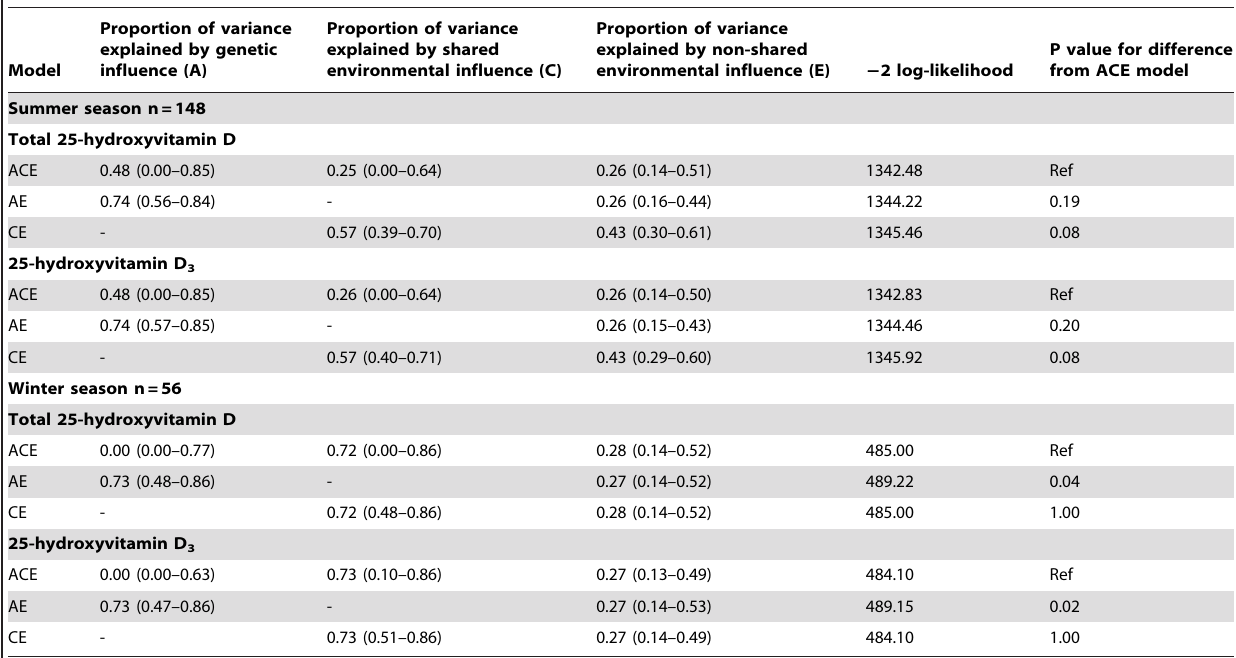
Table 3. The age-adjusted genetic, shared and non-shared (individual specific) environmental influences on variance of total serum 25-hydroxyvitamin D and 25-hydroxyvitamin D 3 levels (95% CI) during summer and winter seasons among Swedish adult